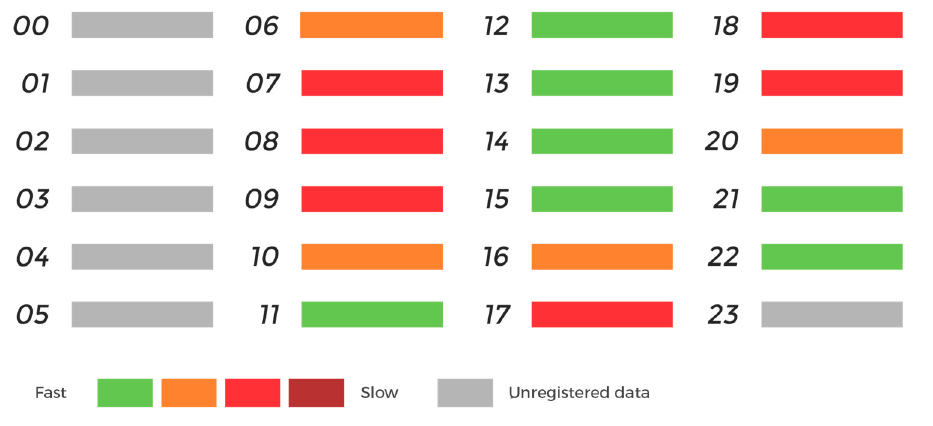
Figure 5. Traffic peak hours in the area of interest (image by Rosario Di